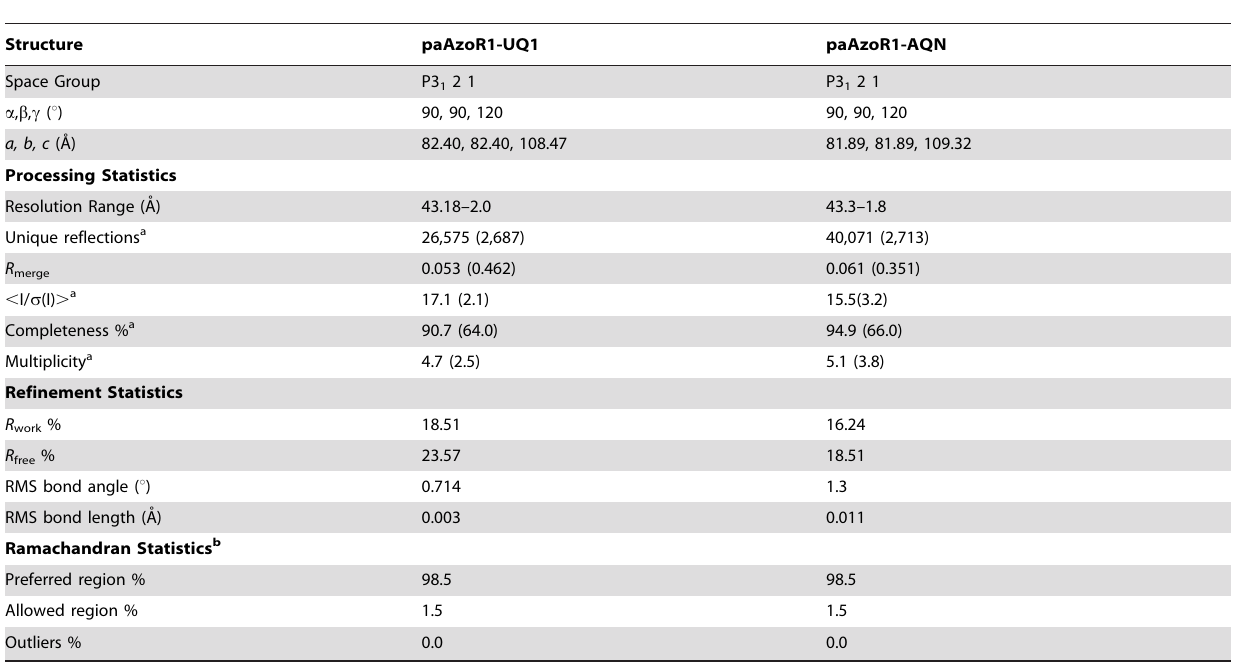
Table 1. Processing and refinement statistics for paAzoR1 complexed with AQN and UQ1.